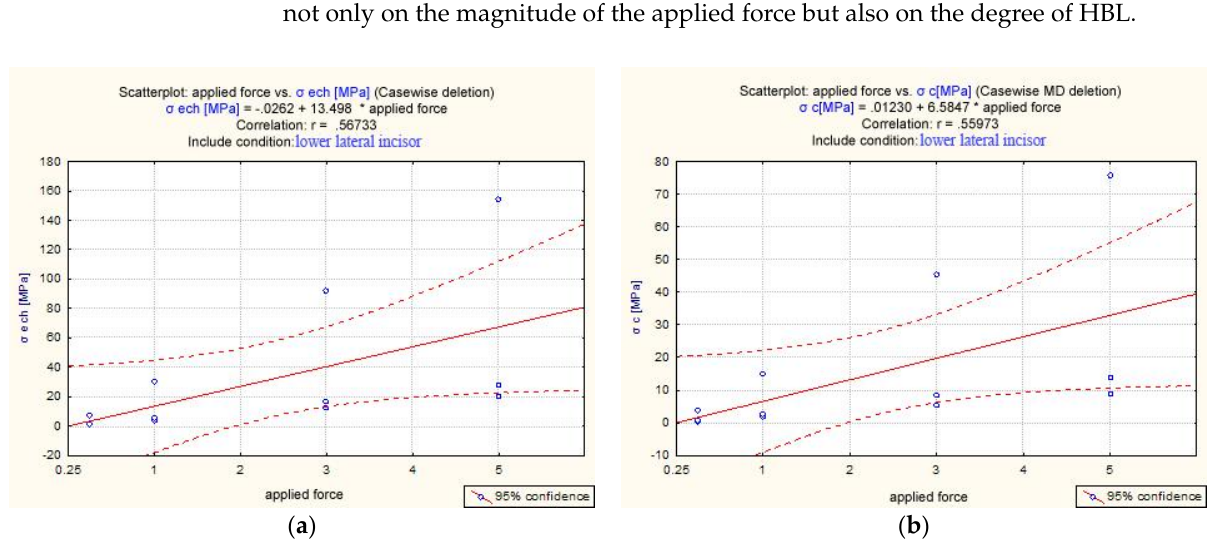
( c ) Figure 14. Regression line of the correlation ( a ) σ ech, ( b ) σ c, and ( c ) f vs. applied force. The values of σ ech presented a uniform increase for no periodontal damage group and for the 33% HBL. However, for the 66% periodontal damage group, σ ech shows an exponential increase. The values of σ c showed the same tendency, but for the 66% perio- dontal damage group, the increase was significantly higher compared with the other two groups. Displacement parameter ( f ) had increased absolute values that were dependent not only on the magnitude of the applied force but also on the degree of HBL. 4. Discussion Currently, there is no consensus as to what the optimal force for orthodontic tooth movement should be; however, most agree that it is up to 1 N [21,22]. Although this may be true theoretically, in practice it is difficult to control and assess the precise force applied to every tooth. As the force magnitude increases, so do the potential unwanted side effects such as undesired tooth movements, external apical root resorption, hyalinization, and patient discomfort [21,23,24]. Due to the inconsistencies in the literature and because of the theoretical nature of the study, we considered various force magnitudes in our simulation, up to 5 N, to illus- trate the effect on periodontal tissues of different force magnitudes on various scenarios of bone loss. In the case of 1 N force, we noted that when the profound periodontium tissues are intact, the forces are evenly distributed along the central region of the root of the central lower incisor, both on the buccal and lingual areas. As the periodontal tissues start to break down, the stress concentrates to a narrower area, mostly around the tooth’s center of rotation. Finally, as the bone loss reaches 66% the crown of the tooth is